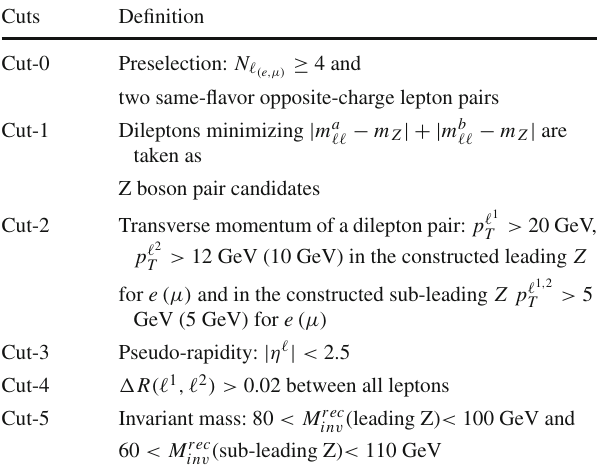
Table 2 Preselection and a set of cuts for the analysis of signal and background events